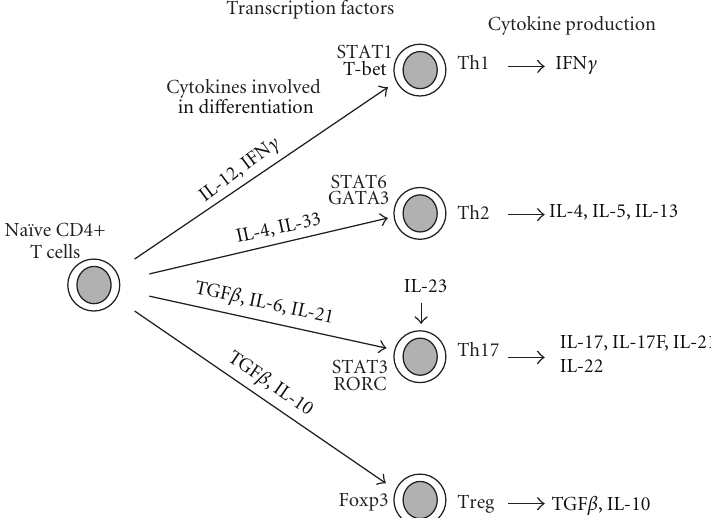
Figure 2: Current view of CD4+ T-cell subsets in humans [27]. Na¨ıve CD4+ T-cells di ff erentiate into several T-cell subsets in the presence of appropriate cytokines. In response to the cytokines, the corresponding signaling molecules and transcription factors are expressed to regulate lineage commitments. Th17 cells require IL-23 for their